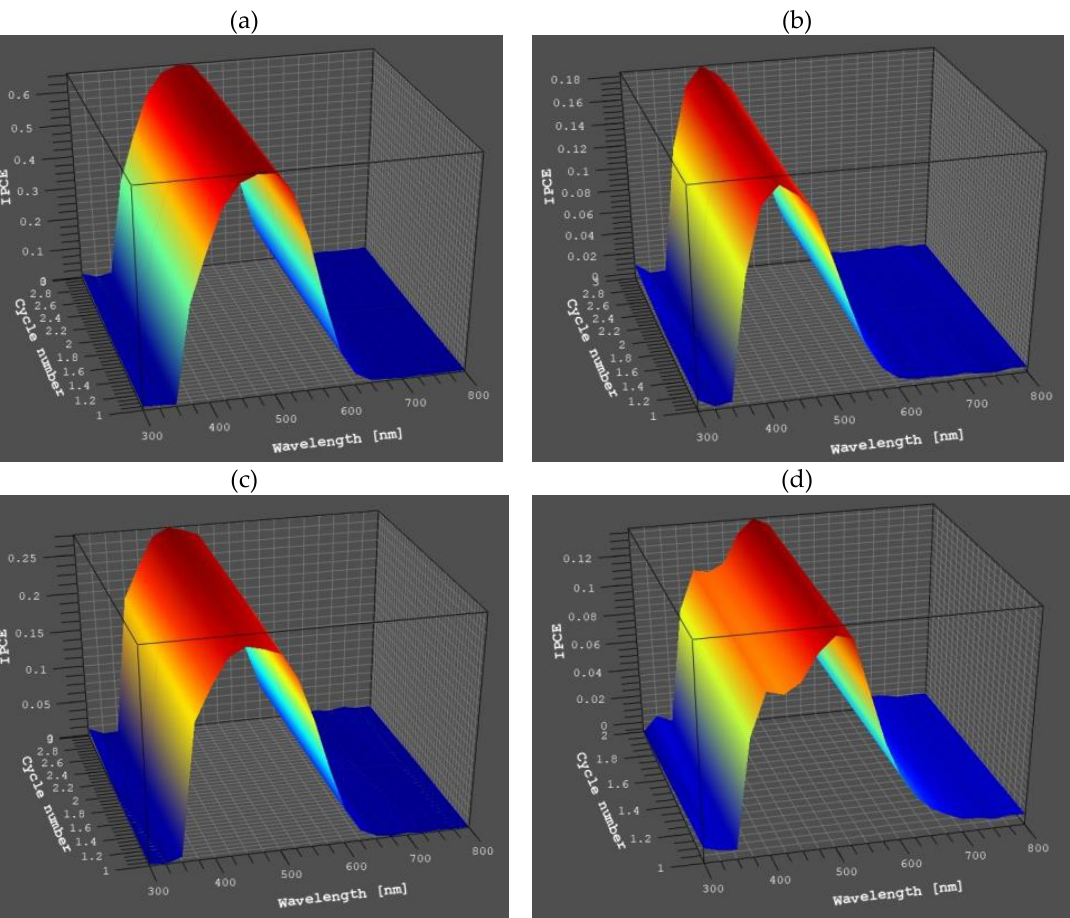
Figure 8. IPCE spectra of prepared devices containing ( a ) 2a, ( b ) 2b, ( c ) 2c and ( d ) N719.